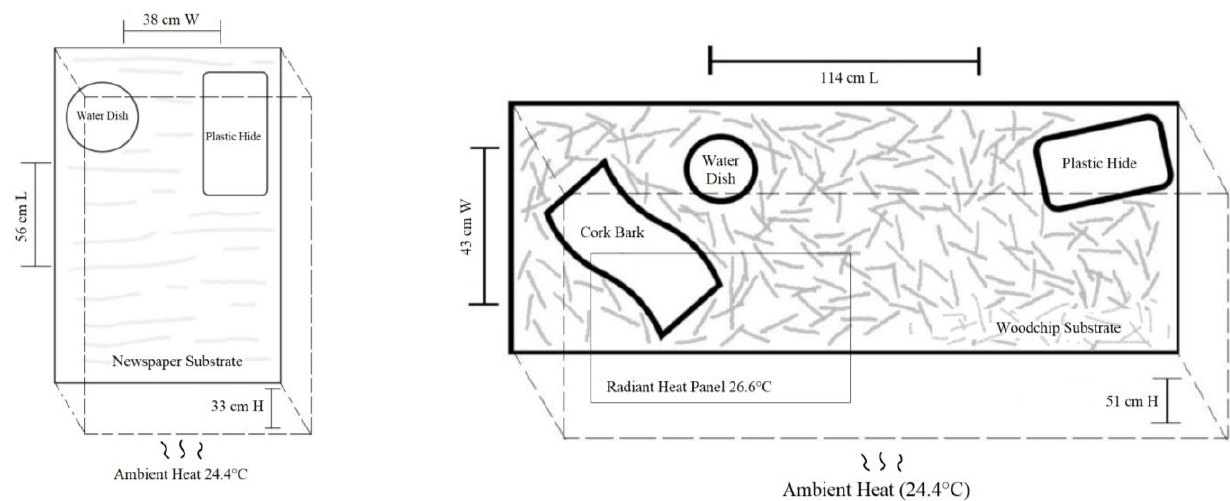
Figure 1 . Top down views of the enclosures for Madagascar giant hognose snakes showing differences between the baseline enclosures (left) and the modified habitats